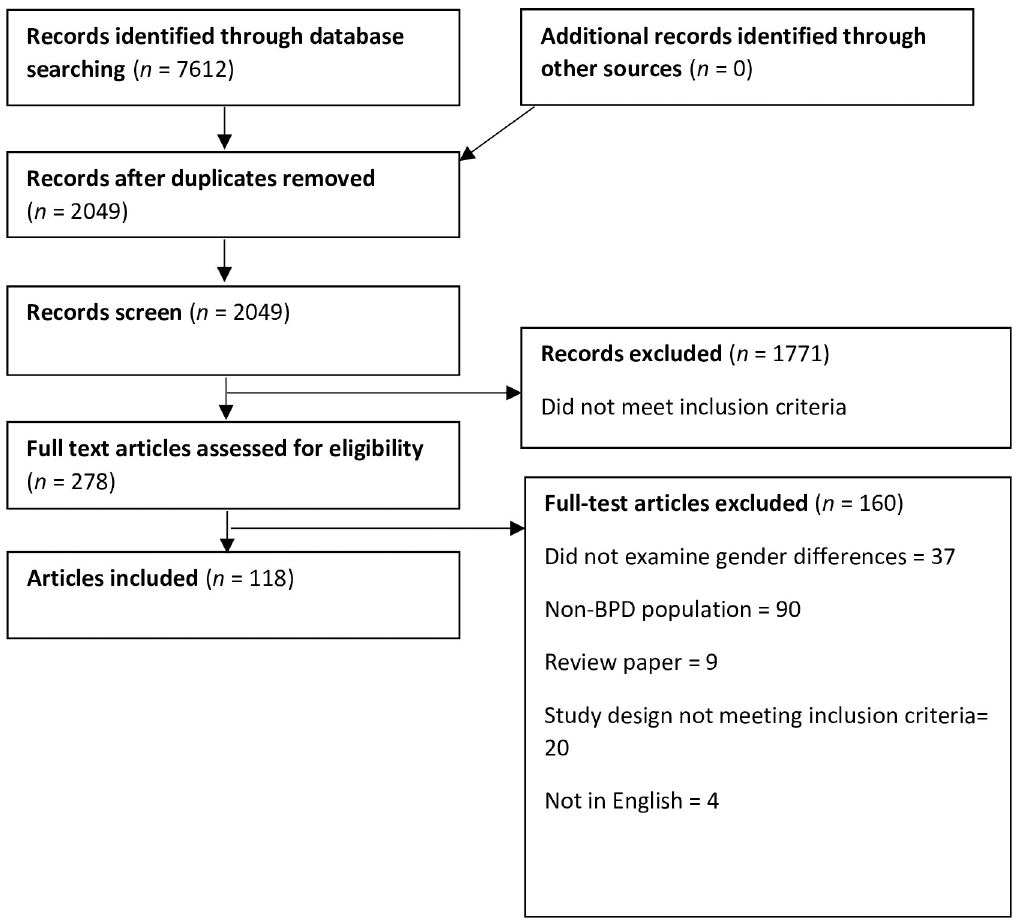
Fig 1. Search results, study selection and inclusion